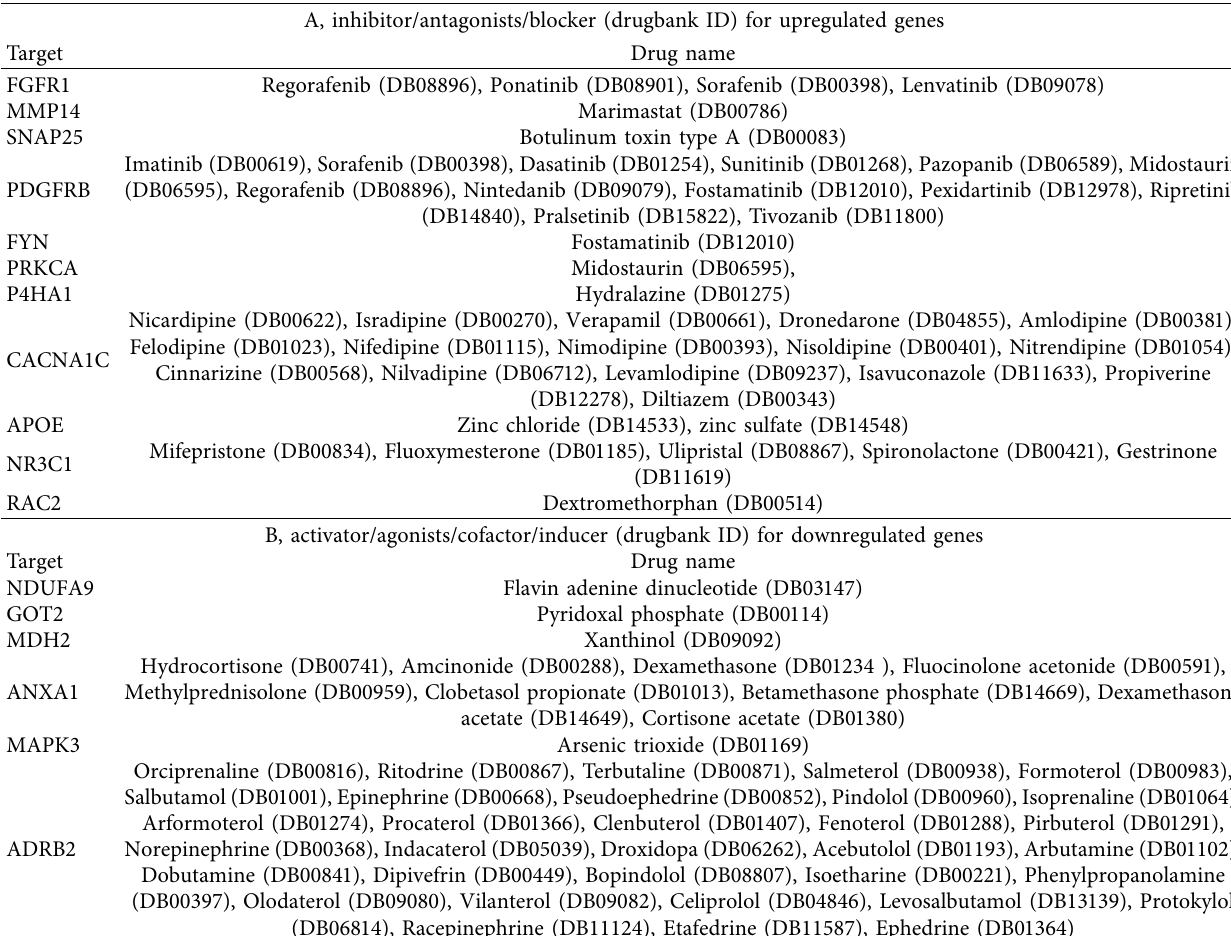
Table 4: A list of approved drugs in the drugbank database acting on some of the hub genes in primary ameloblastoma. A, inhibitor/antagonists/blocker (drugbank ID) for upregulated